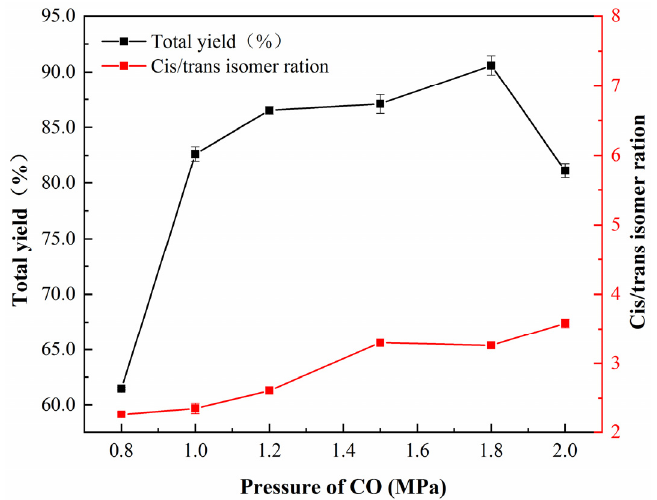
Figure 7. Effect of CO partial pressure on nano-Fe/Pd catalyst activity in the reaction. Reaction conditions: catalyst (10 mg), acetylene (11 mmol), MeOH (20 mL), KI (112 mg), P total = 4.0 MPa, T = 323.2 K, t = 6 h.